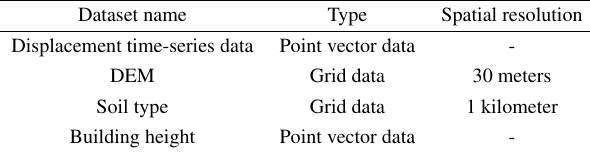
Figure 2. The whole process of the Graph-TAP framework Table 2. The information of